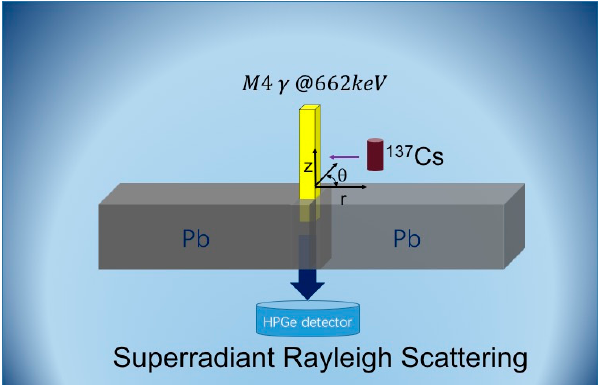
Figure 1. Schematic representation of the experiment. The activated sample (1 mm × 1.5 cm × 3 cm, yellow color) with the normal vector in the E-W direction was surrounded by the Pb blocks (8 × 4 cm × 8 cm × 16 cm). A 2.5-mCi 137 Cs point source was placed at the location of (r, θ ). The Pb blocks protected the HPGe detector from the leak exposure of 137 Cs source, except the end-fire mode (dark blue arrow) along the z axis. The lateral impinging multipolar MeV γ s from 137 Cs gave rise to the superradiant Rayleigh scattering into the end-fire mode detected by a HPGe detector, which was located below the Pb shielding.